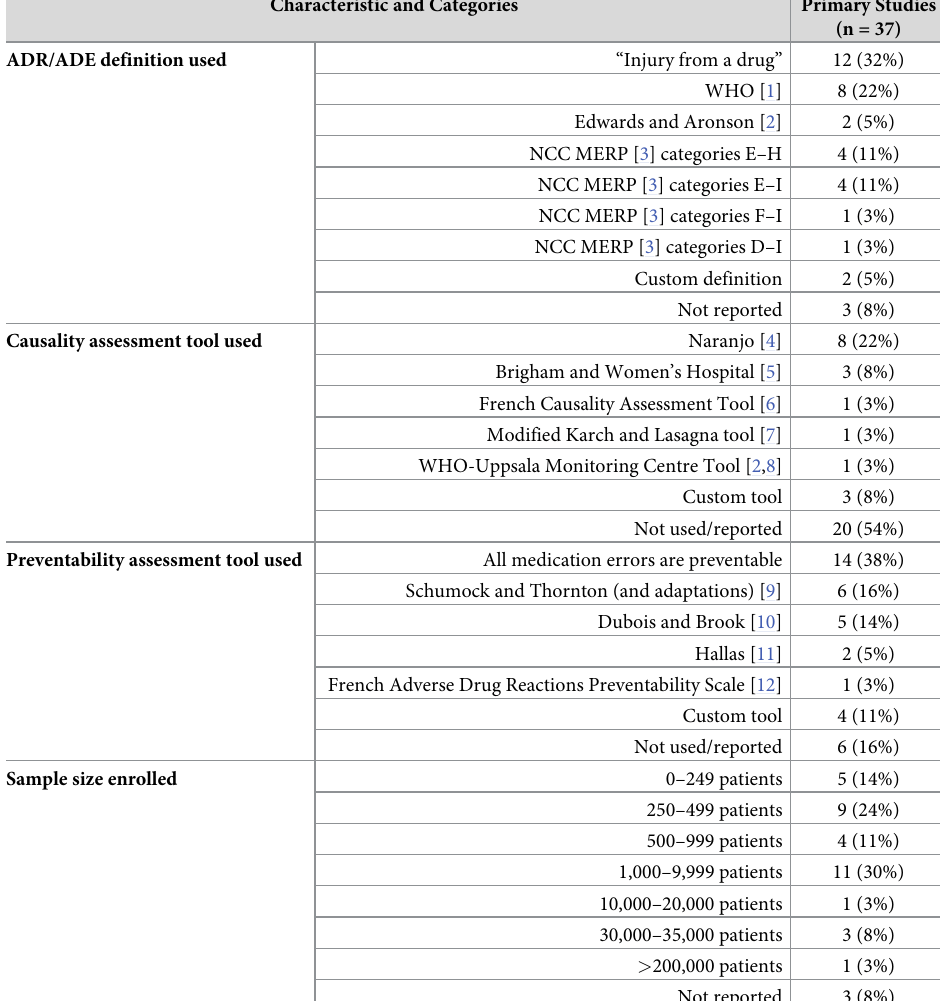
Table 2. Additional characteristics of included primary